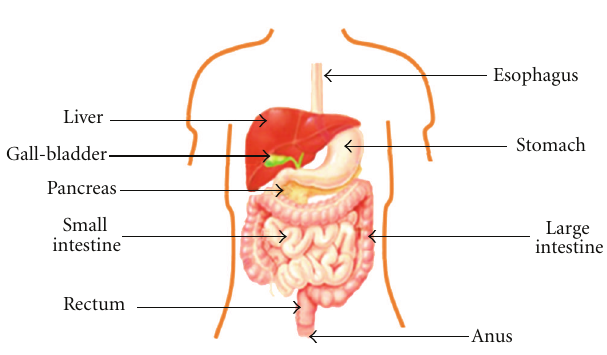
Figure 1: Architecture of the human GI tract